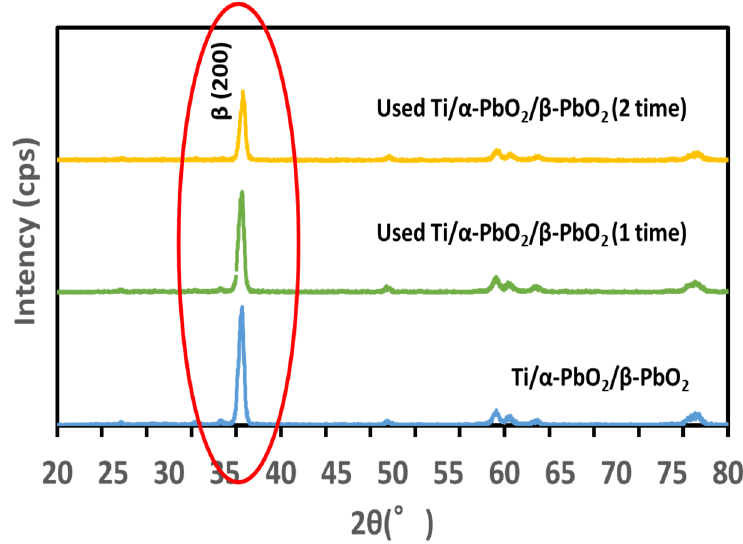
Figure 10. XRD of Ti/α-PbO 2 /β-PbO 2 before and after five cycles. Na 2 SO 4 electrolyte: 0.01 mol L −1 ; reaction time: 1 h; electrode distance: 3 cm; initial pH: 6.0; reaction temperature: 25 °C; MB: 0.05 g L −1 ; and cell voltage: 20 V.